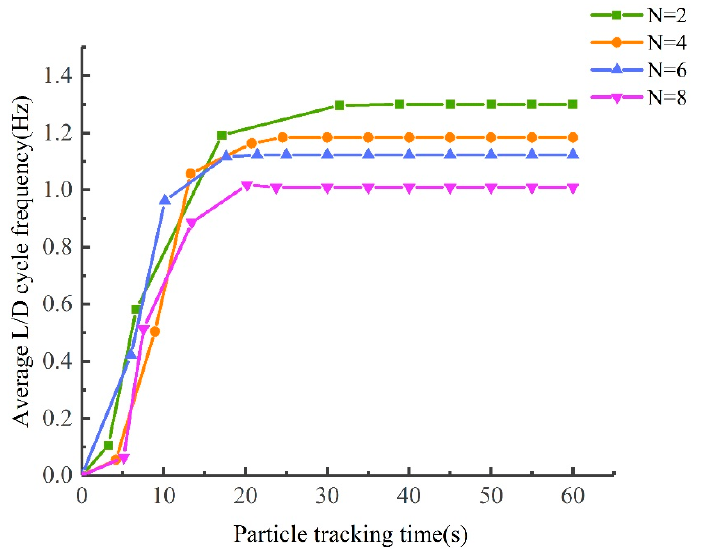
Figure A2. Average L/D cycle frequency of particles as a function of particle tracking time for PBRs with different numbers of ribs.